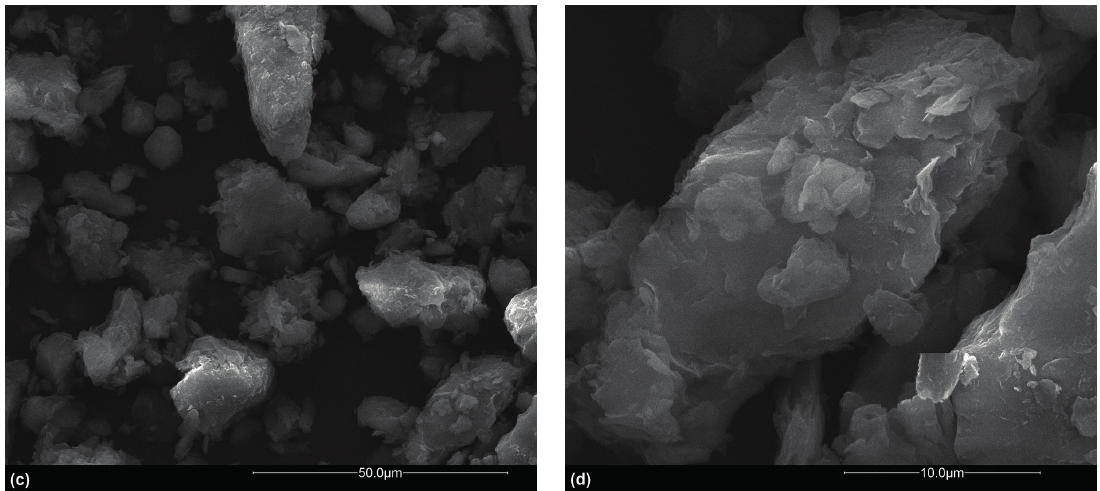
Figure 1. Scanning electronic microscope (SEM) images of ( a ) original cultivated cropland soil sample at working distances of 50 µm; and ( b ) 10 µm; and ( c ) phosphorus solution treated soil sample at working distances of 50 µm; and ( d ) 10